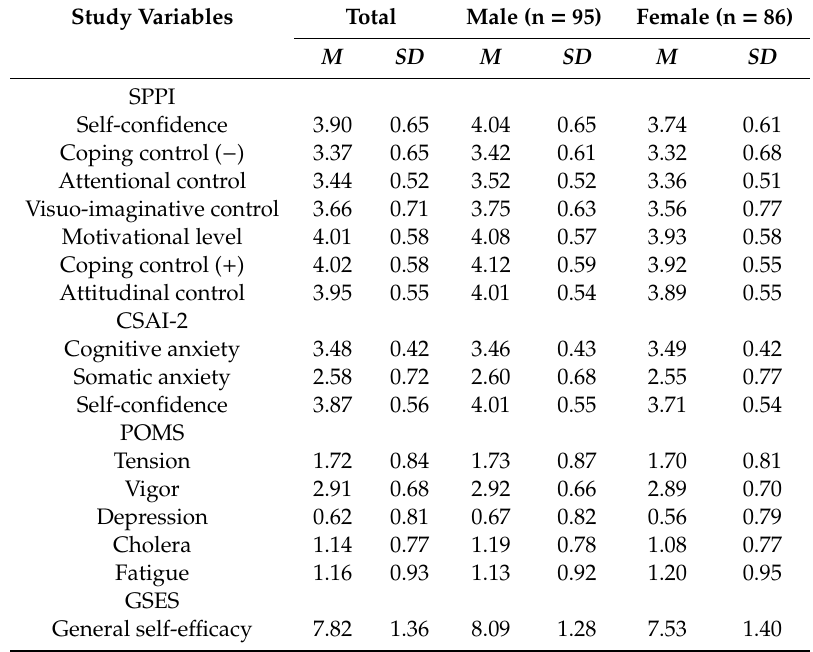
Table 1. Means and typical deviations of Psychological Inventory of Sports Performance (SPPI), Competitive State Anxiety Inventory-2 (CSAI-2), Profile of Mood States Questionnaire (POMS) and General Self-E ffi cacy Scale (GSES) scores.